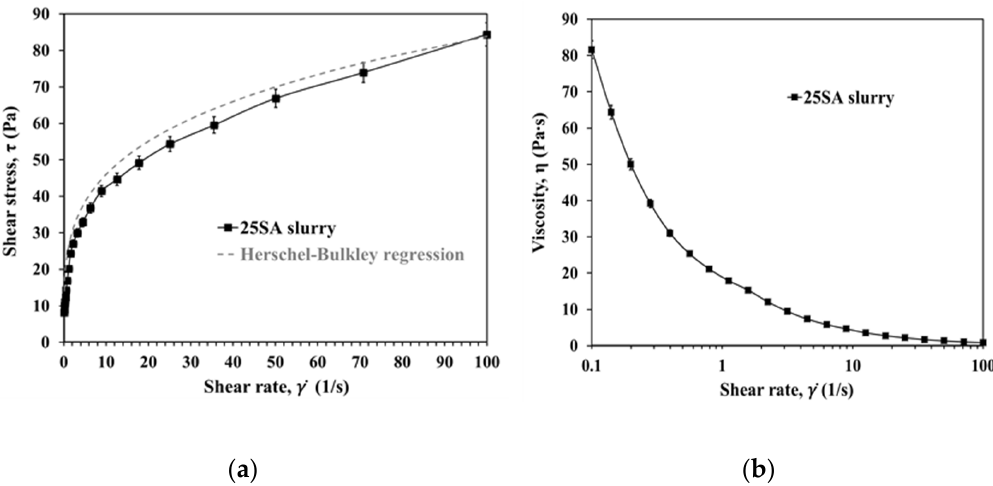
Figure A1. ( a ) Flow curve; ( b ) viscosity curve of the 25SA suspension. The relative error percentages for the shear stress and viscosity values were ± 1.9% and ± 1.5%, respectively.